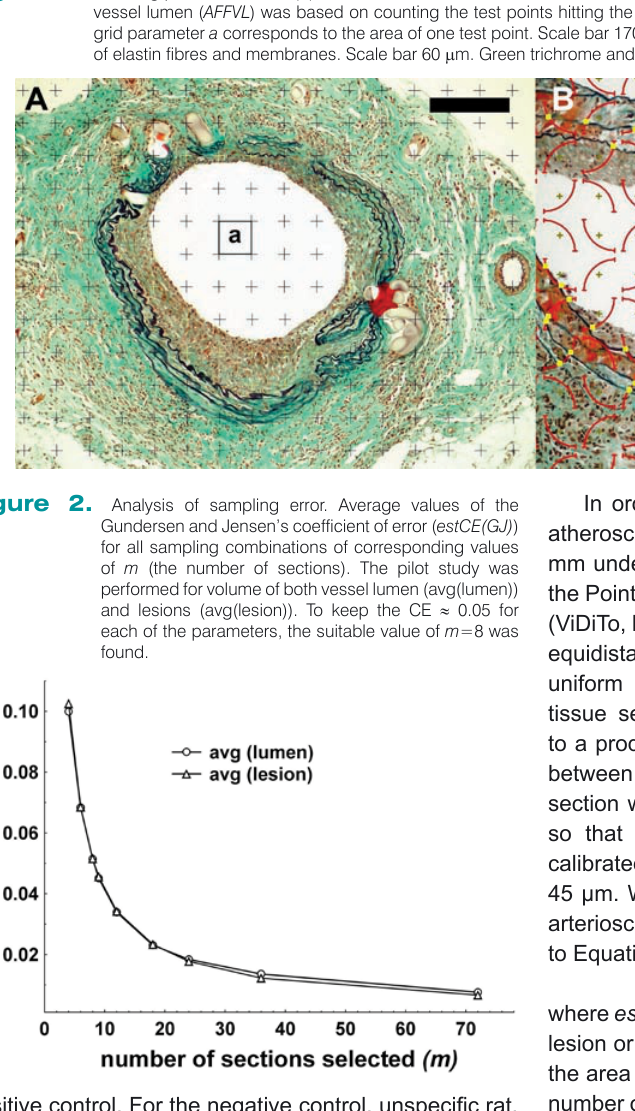
Figure 1. Counting points and lines. (A) Assessment of the estimated volume of the atherosclerotic lesion ( estV ) and the area fraction of the free vessel lumen ( AFFVL ) was based on counting the test points hitting the lesion (highlighted as yellow), or the lumen, respectively. The grid parameter a corresponds to the area of one test point. Scale bar 170 m m. (B) Circular arcs were used for estimating length density of elastin fibres and membranes. Scale bar 60 m m. Green trichrome and Verhoeff’s hematoxylin stain.